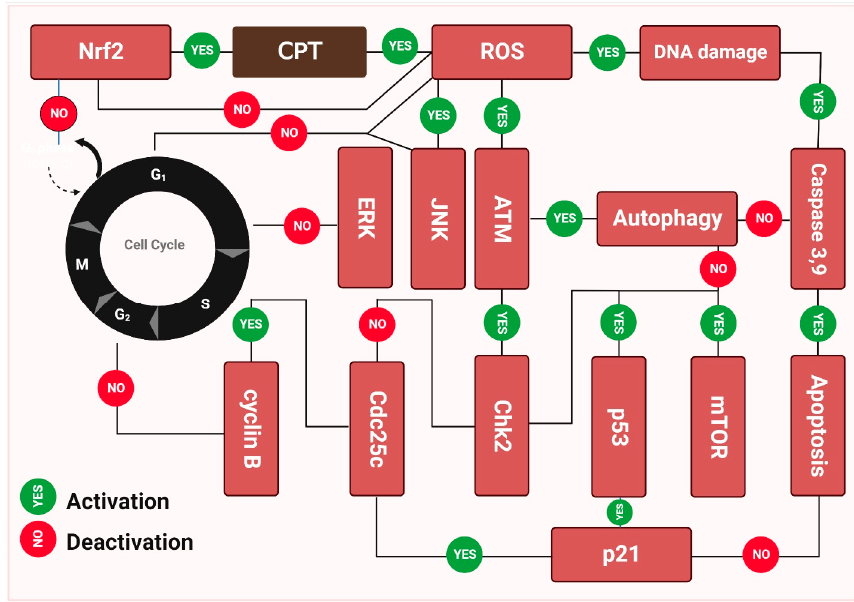
Figure 3. The molecular basis behind camptothecin (CPT’s) antitumor activity. The capacity of camptothecin to bond with double-stranded DNA is a major factor in its anti-tumor effect. During the replication process, these enzymes nick the double-stranded DNA, releasing a single-stranded copy. In addition, they significantly minimize supercoiling in DNA double helix structures. Camp- tothecin inhibits cancer growth by inhibiting topoisomerase-I catalytic activity after a non-covalent binding, leading to elevated levels of p21, p53, and mTOR expression. As opposed to this, camp- tothecin stimulates ERK and NERF2, both of which are upregulated by the drug. The cell death seen in Figure 3 was the result of these molecular processes, which triggered apoptosis [180,181]. Clinical trials involving camptothecin (CPT) were put on hold for the time being, although investigation into the compound’s mechanism of action has proceeded. Many anticancer medications work by damaging deoxyribonucleic acid (DNA) strands in cancer cells while leaving healthy ones intact. Camptothecin’s (CPT) topoisomerase I (Top I) in- hibition is the key to its anticancer activity, which was discovered in the 1980s [182]. DNA replication requires the latter. More specifically, camptothecin (CPT) was discovered to inhibit the Top1-DNA complex, as opposed to the free Top1 enzyme. The discovery of this molecular target of camptothecin (CPT) has led to potential developments in the chemis- try and SAR of camptothecin (CPT), permitting the manufacture of analogues with en- hanced potency, superior selectivity, and consequently reduced toxicity [183]. In order to achieve selectivity, it is necessary to target cells with a higher expression of the TOP I enzyme, which is primarily found in cancer cells [184]. Those with a higher concentration of camptothecin (CPT) in their systems are more sensitive to it [185]. Accordingly, the cytotoxic impact of camptothecin (CPT) is enhanced in cells with elevated levels of Top I. Camptothecin (CPT) has several undesirable side effects during clinical use. These include nausea, stomach cramps, diarrhea, and even hemorrhagic cystic illness [185]. Camptothecin’s (CPT) target enzyme, Top1 Top I, elucidated key aspects of the drug’s mechanism of action. Supercoiling, caused by DNA and RNA polymerases, occurs in the DNA double helix during replication [186]. Top1 regulates DNA topology, which alleviates supercoiled DNA [187]. It cuts the supercoiled part of the DNA, resulting in a